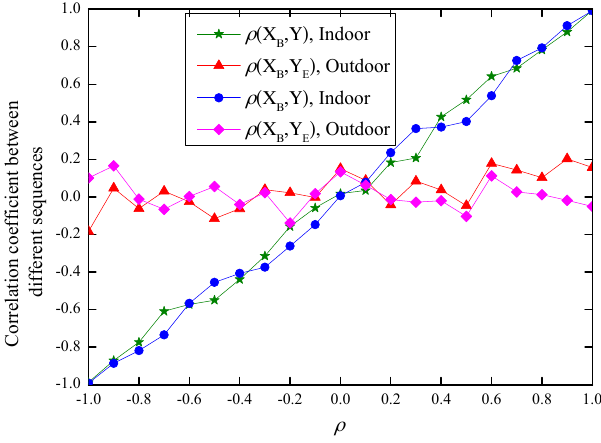
Figure 5. The experimental results of ρ ( X